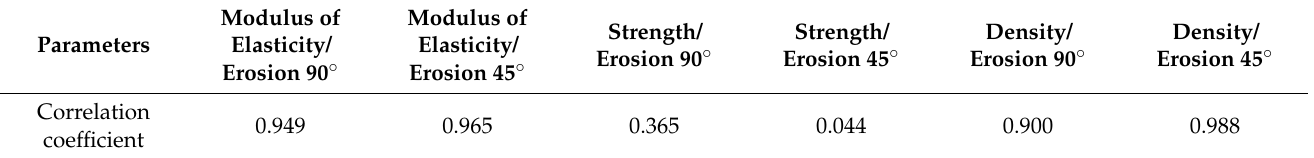
Table 4. Correlation coefficients between physical and mechanical parameters and wear at different impingement